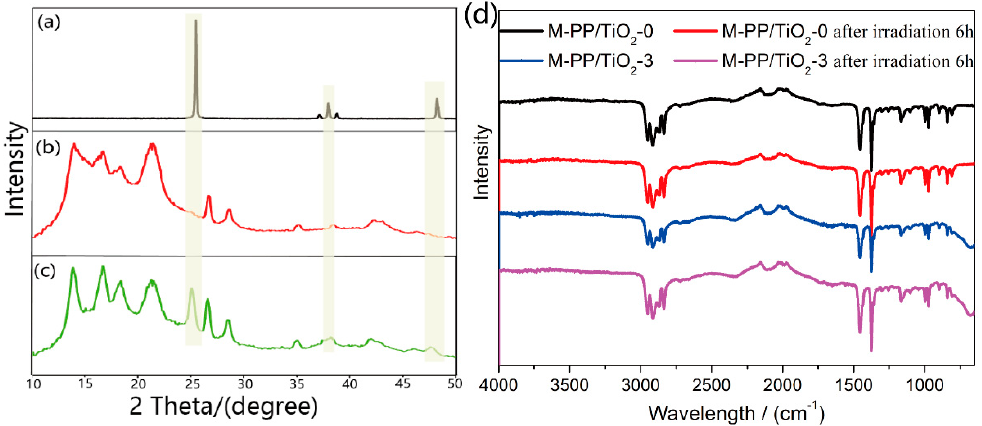
Figure 4. X-ray di ff raction (XRD) patterns of ( a ) TiO 2 ; ( b ) M-PP / TiO 2 -0; ( c ) M-PP / TiO 2 -3; and ( d ) Fourier Figure 4. X-ray diffraction (XRD) patterns of ( a ) TiO 2 ; ( b ) M-PP/TiO 2 -0;( c ) M-PP/TiO 2 -3; and ( d ) transform infrared spectroscopy (FTIR) spectra of M-PP / TiO 2 Fourier transform infrared spectroscopy (FTIR) spectra of M-PP/TiO 2 membranes.